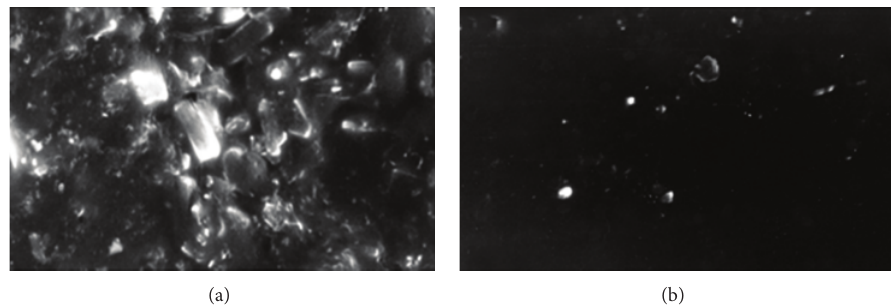
Figure 7: SEM of optimised formulation F12 (a) without poloxamer P188 and (b) with poloxamer